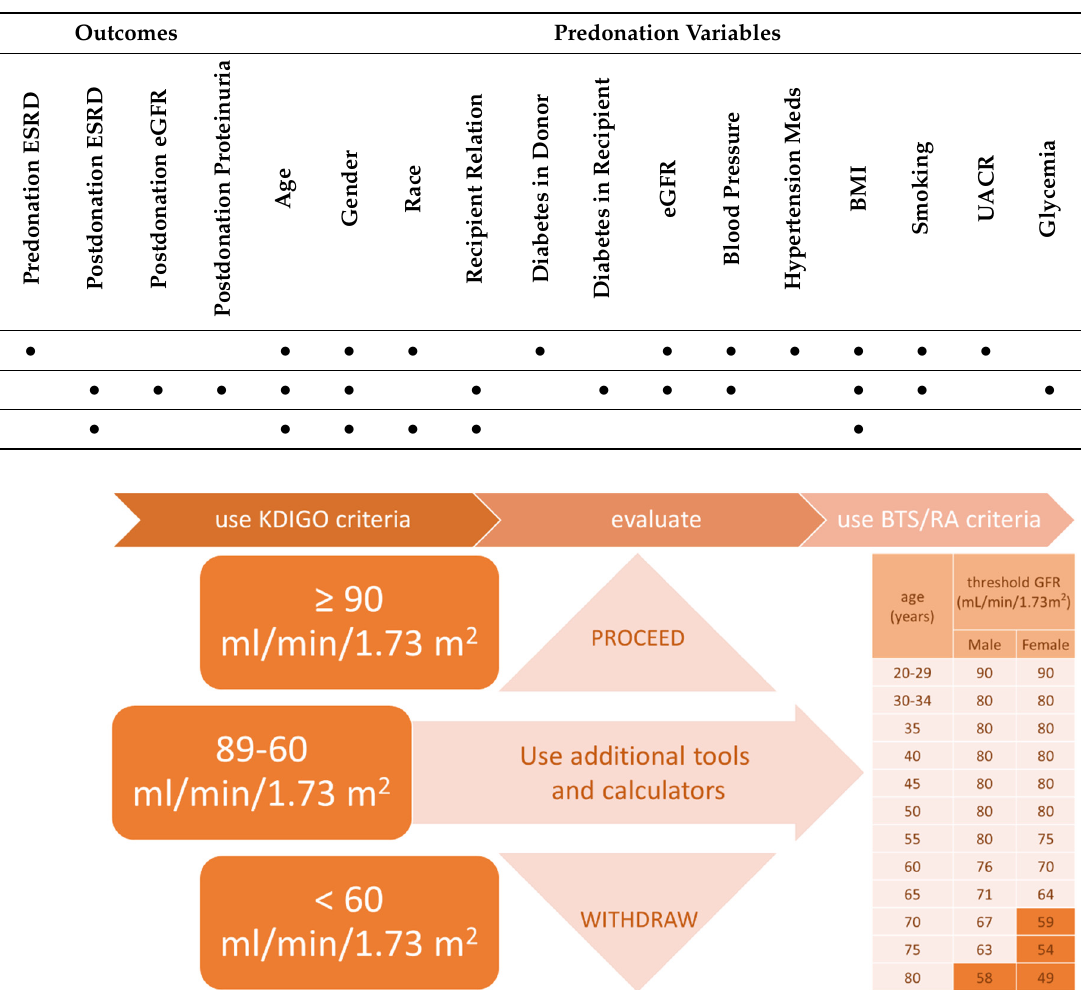
Figure 1. The decision-making flowchart for assessing pre-donation kidney function in a living donor. Conditions subsequently affecting kidneys (e.g., hypertension, diabetes, autoimmune disorders) should be excluded in further evaluation irrespective of the value of the acceptable eGFR (even above 90 mL/min/1.73 m 2 ).